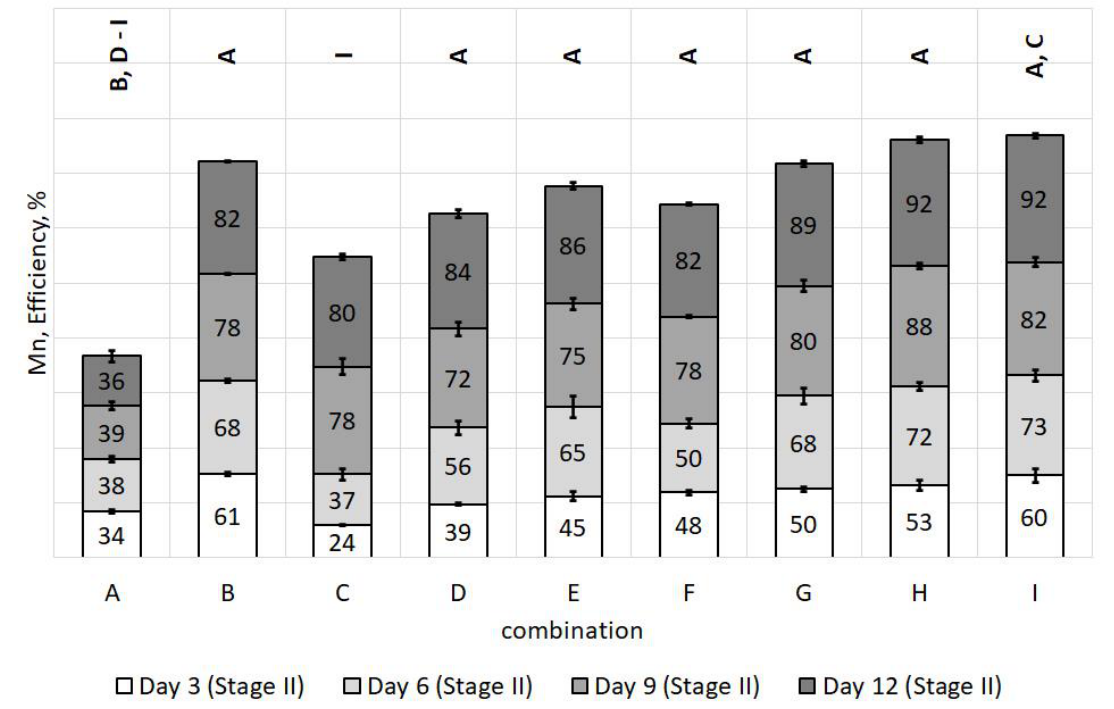
Figure 18. Effectiveness of Mn release to the dissolved fraction of leachate (Stage II).